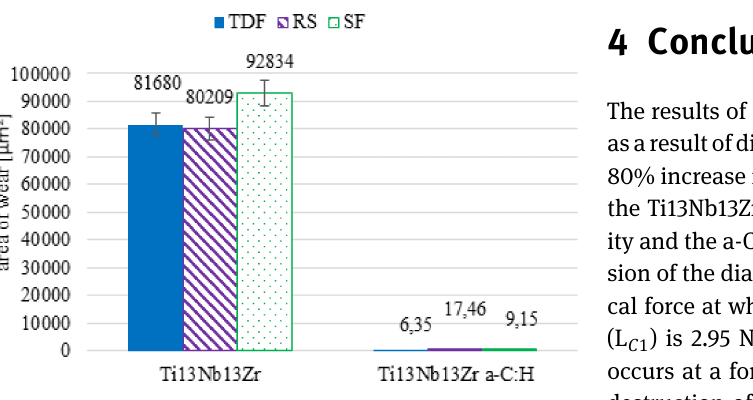
Figure 16: The area of wear in a